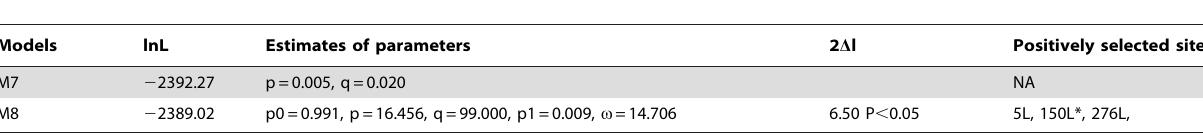
Table 8. Site-specific tests for positive selection on HPV-58 L1.